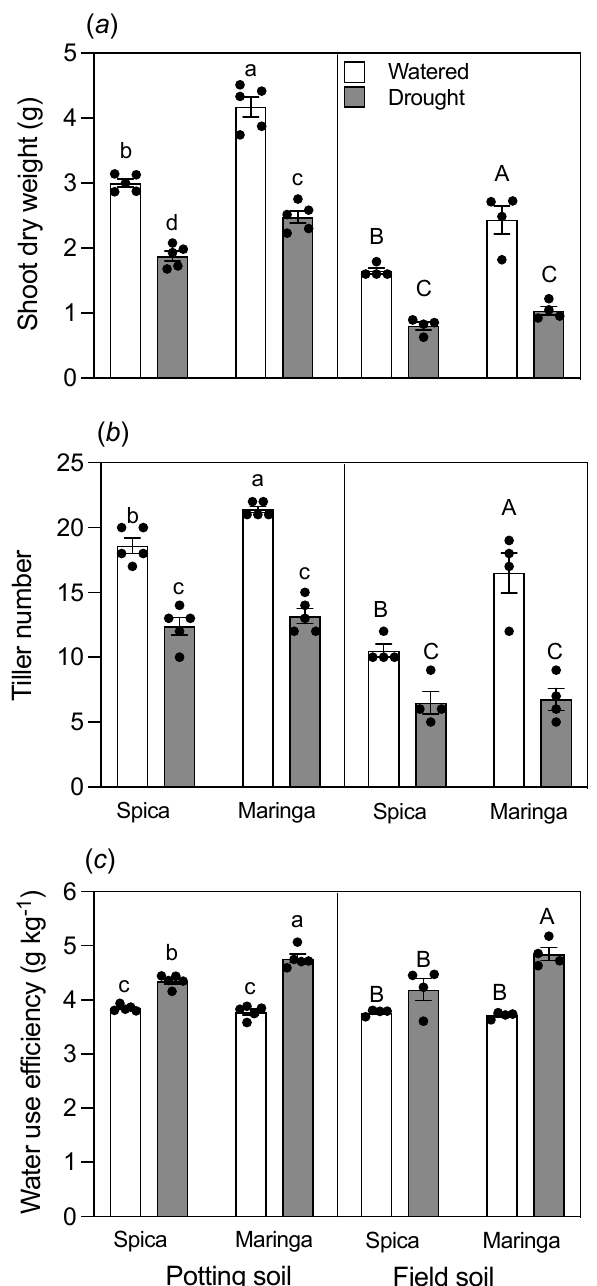
Figure 3. Effect of drought on shoot biomass, tiller number, and water use efficiency. Shoot dry weight ( a ), tiller number ( b ), and water use efficiency ( c ) of genotypes grown for 28 days in well-watered (empty bars) and drought-treated (filled bars) potting and field soils. Water use efficiency is defined as the amount of shoot biomass generated per unit of water taken up. Individual values are shown as circles, and error bars represent ± SE of the mean for either five replicates (potting soil) or four replicates (field soil). Data for potting and field soils were analyzed separately by two-way ANOVAs. Different lowercase letters reflect significant differences between treatments as determined by the Tukey test at p < 0.05 for potting soil, whereas different uppercase letters reflect significant differences between treatments at p < 0.05 for field soil. The interaction between water and cultivar factors for potting soil was ( a ) significant at p < 0.05 for shoot dry weight, ( b ) not significant for tiller number, and ( c ) not significant for water use efficiency. The interaction between water and cultivar factors for field soil was ( a ) significant at p < 0.05 for shoot dry weight, ( b ) significant at p < 0.05 for tiller number, and ( c ) significant at p < 0.05 for water use